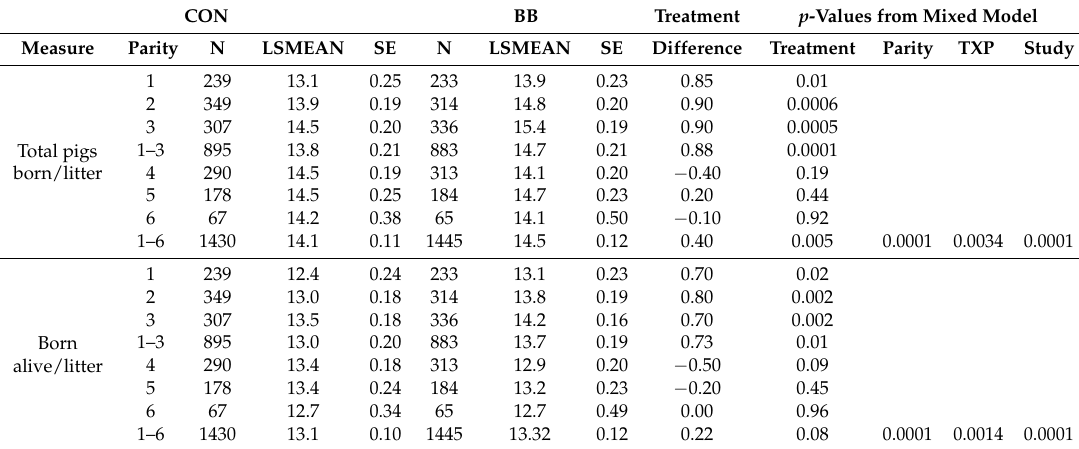
Table 4. Results for Total born/litter and Born alive/litter using Mixed Models and parities 1 to 6 for 10 farm sites for Control (CON) and BOARBETTER (BB) treatment groups. CON BB Treatment p -Values from Mixed Model Measure Parity N LSMEAN SE N LSMEAN SE Difference Treatment Parity TXP Study